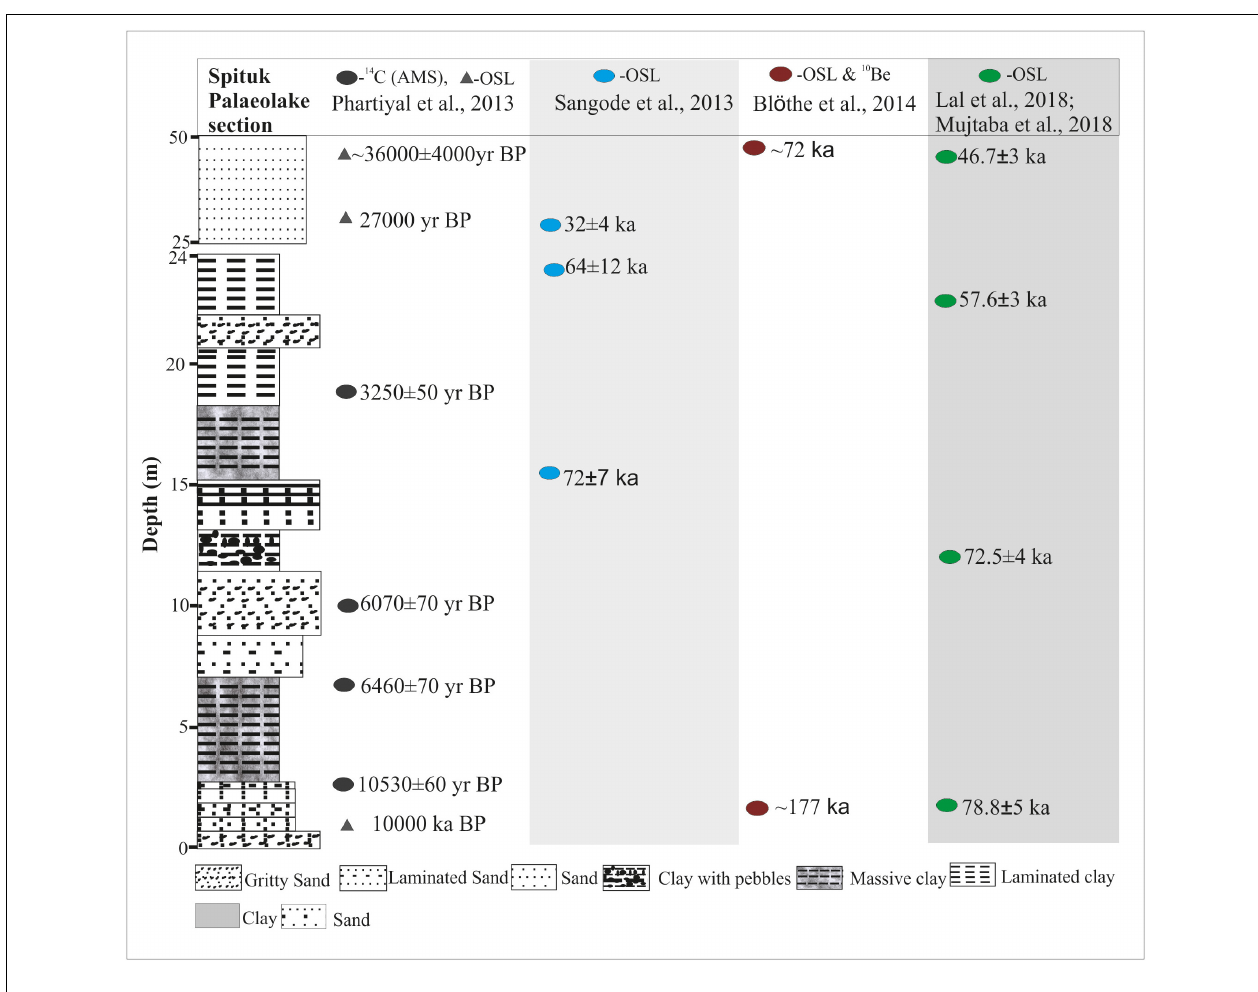
FIGURE 6 | Litholog of Spituk palaeolake sedimentary sequence situated near Leh city on the right bank of the Indus River on Leh-Srinagar road used as an example to explain age discrepancy. The lithological description of the section is fairly consistent in studies carried out by different workers. However, there is a discrepancy in age estimated through different dating techniques (see text for